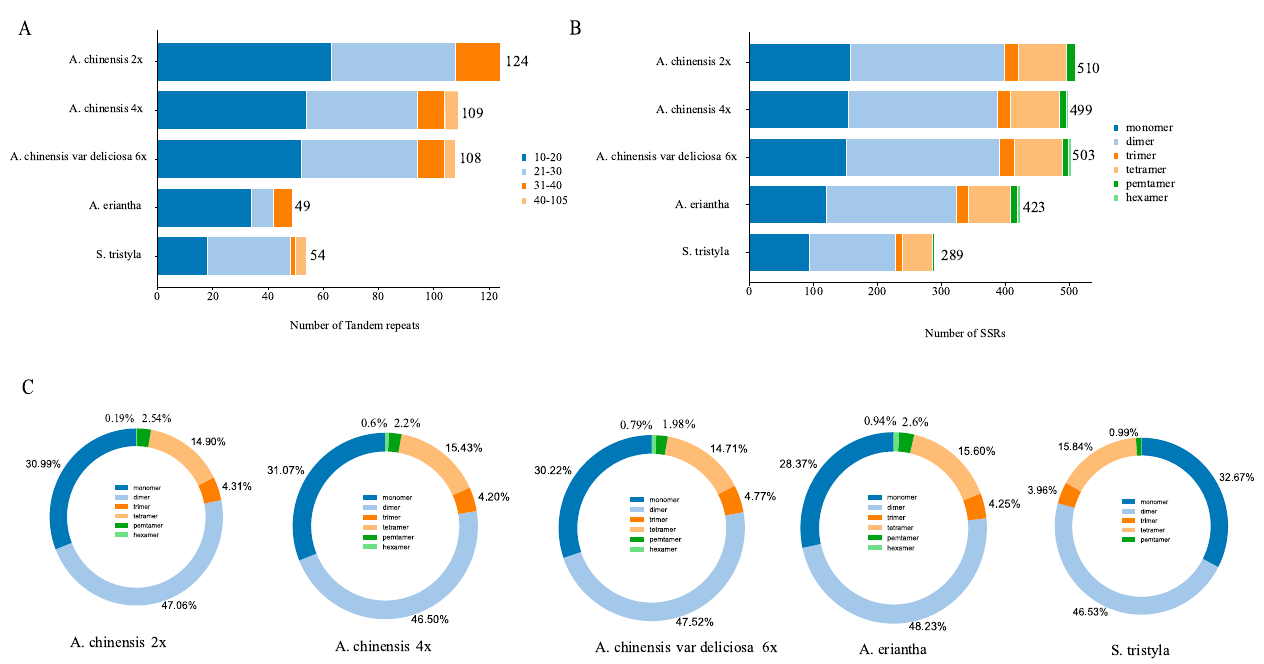
Figure 2. The tandem and SSR repeats in five Actiniaceae mitogenomes. ( A ) The number of tandem repeats. ( B ) The number of SSRs. ( C ) Pie chart for SSR distribution. The colors represent different types of SSRs.